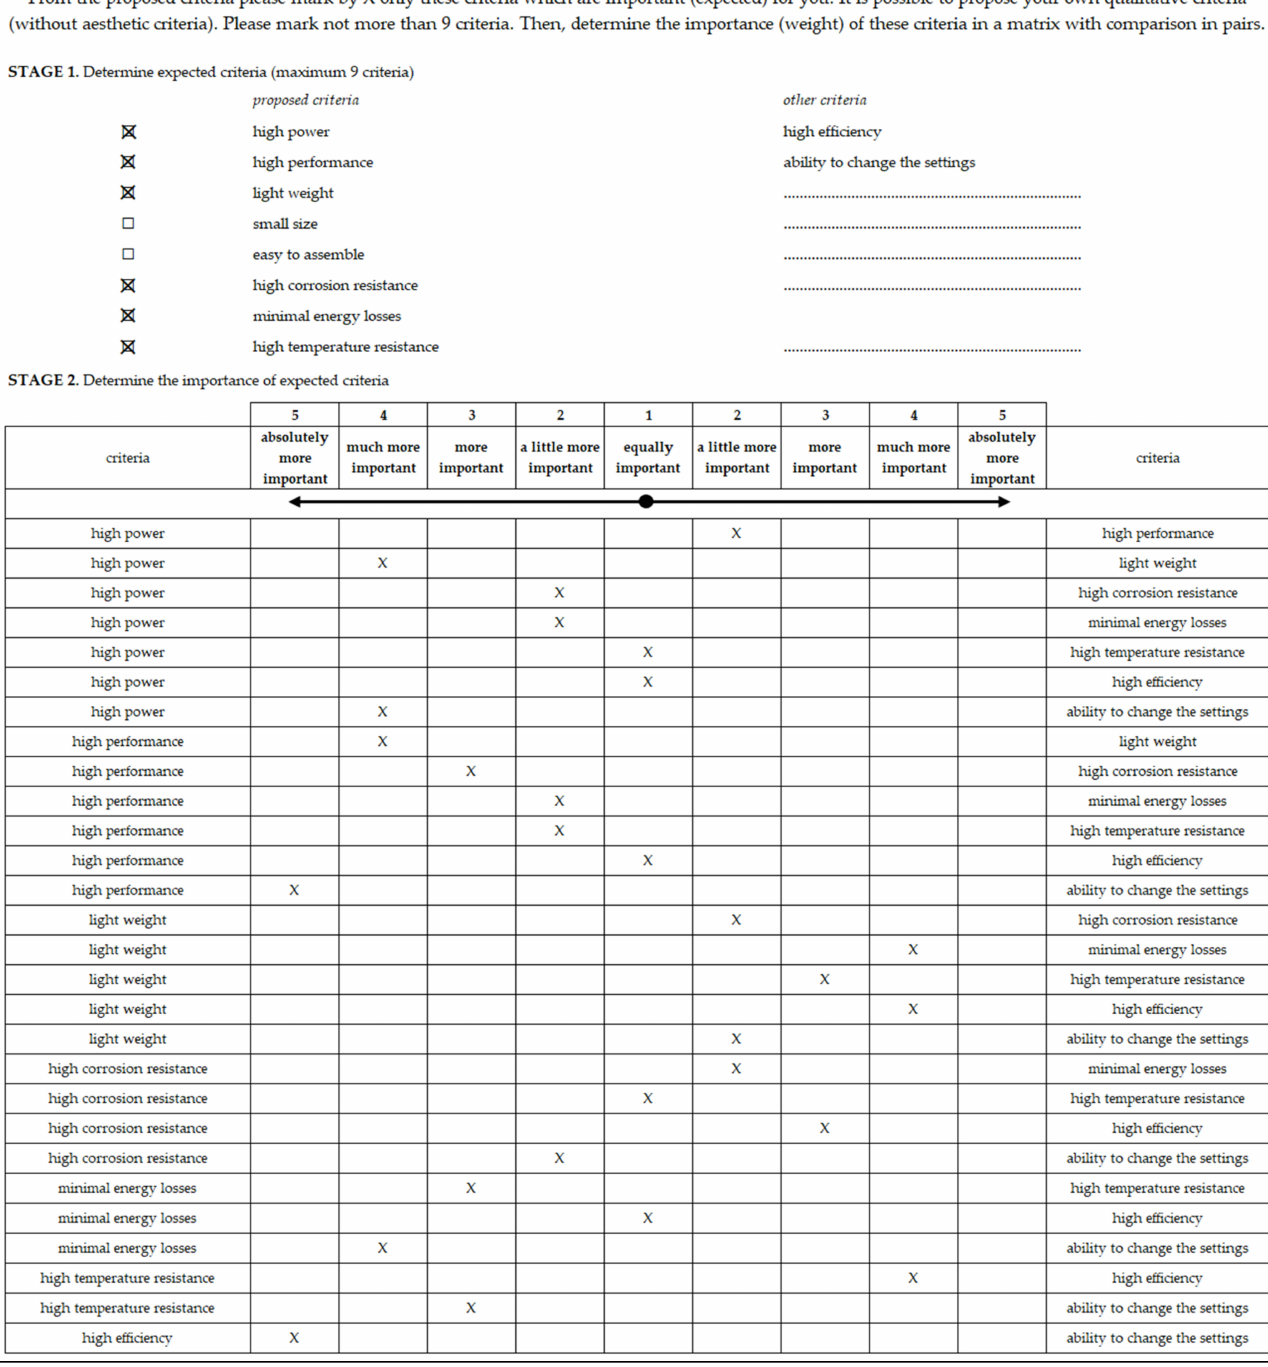
Figure 9. Results from a questionnaire about customer expectations for qualitative criteria. Own